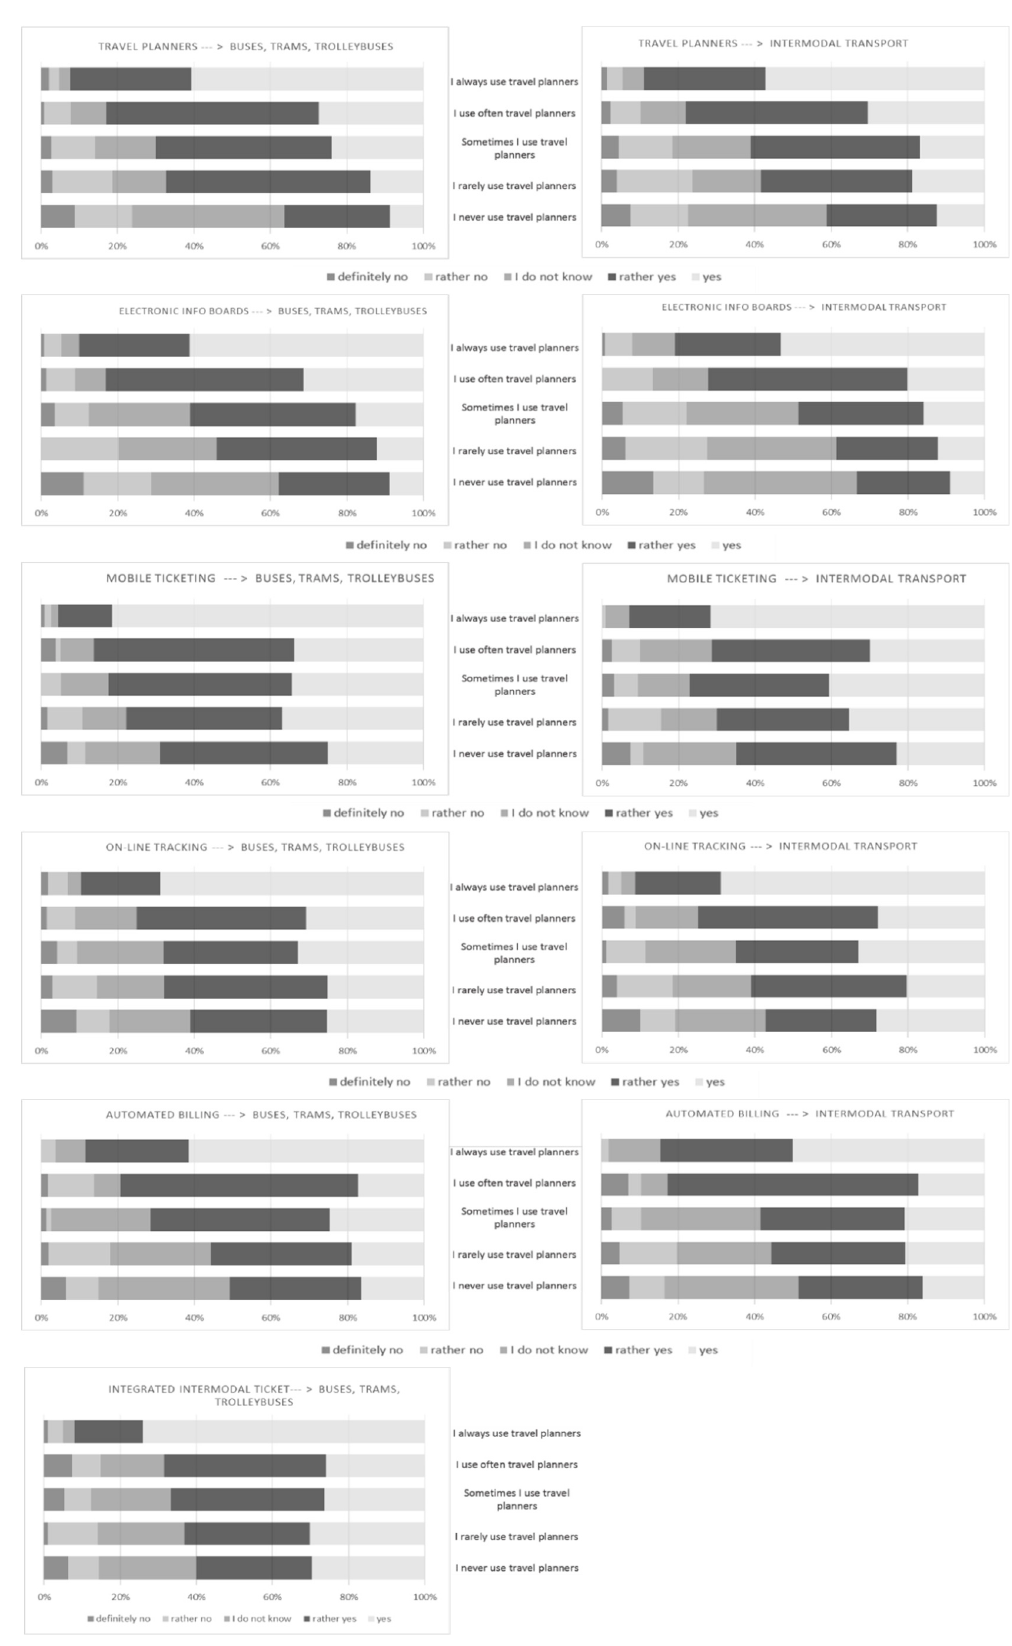
Figure 4. The relationship between the frequency of ICT use and the perception of how a given ICT encourages the use of PT (RQ5).